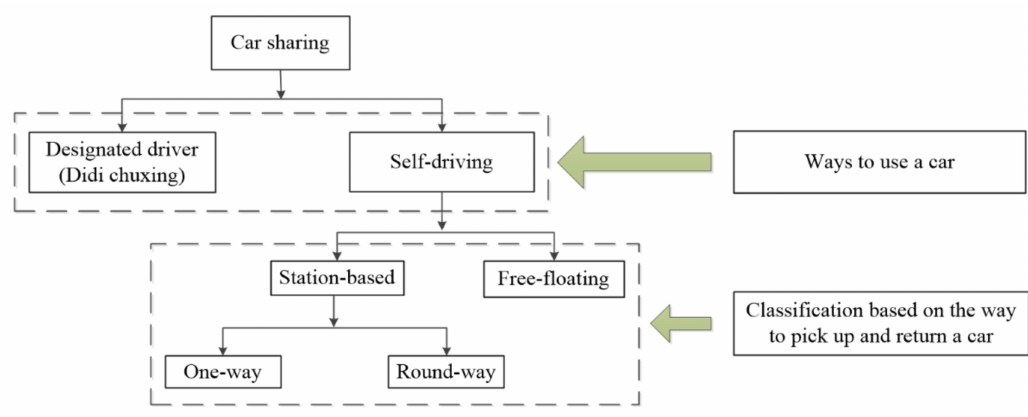
Figure 1. The modes of car